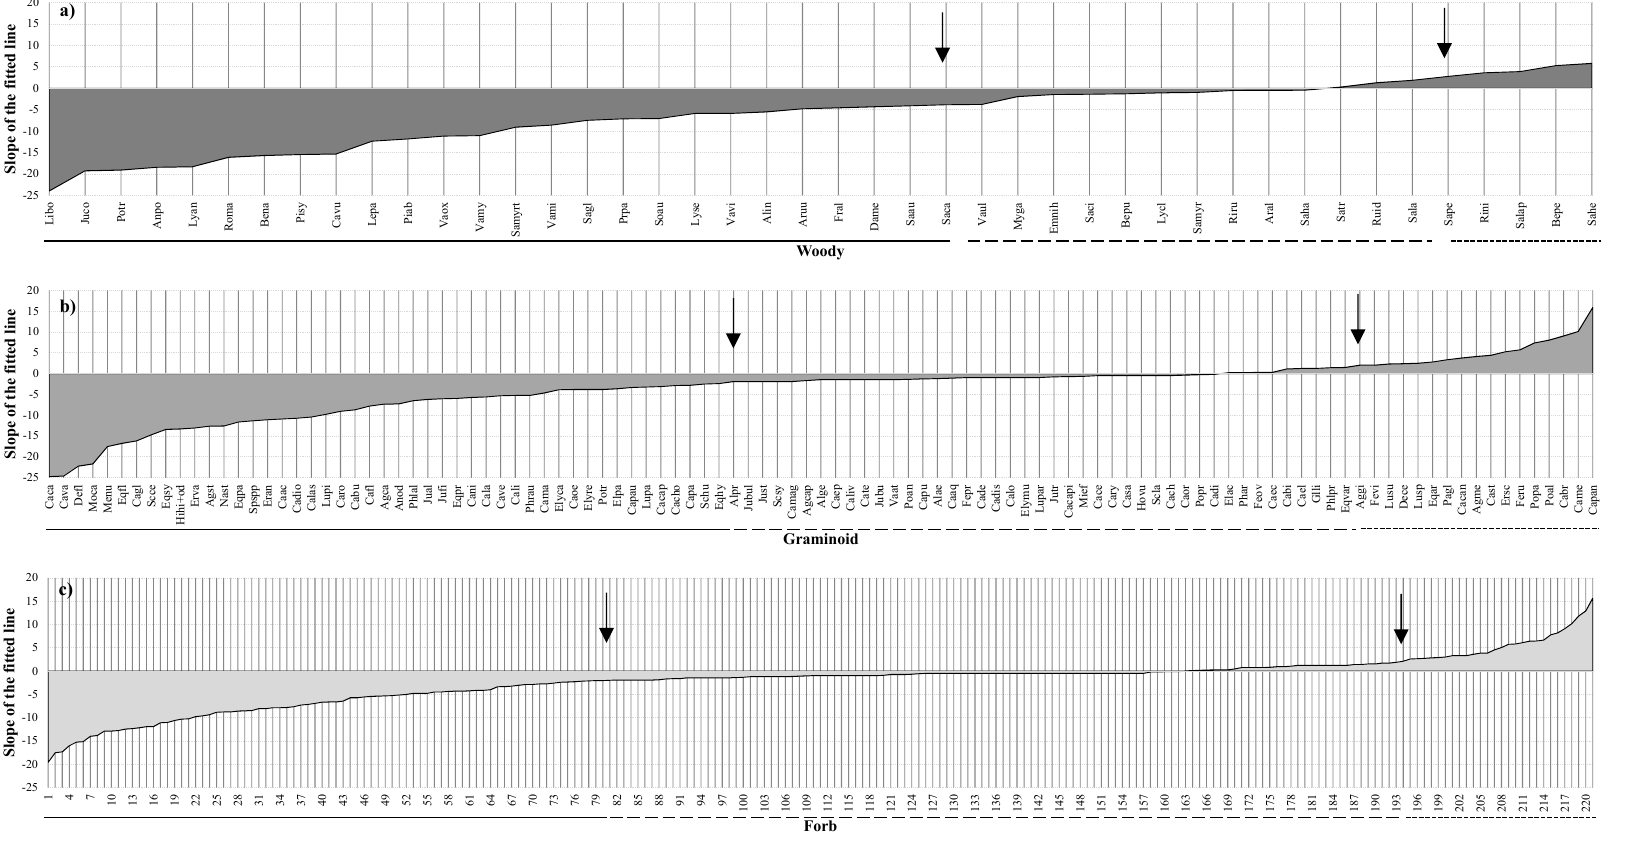
Figure 4. Regression coefficients of the species-specific linear regressions between the relative presence of a species and the mean percentage of regulation separated for each life form group (Woody species (a), graminoids (b) and forbs (c)). Different regression coefficients are indicated with a line below and with arrows at the top of each. The full names of the species are in Annex 1.